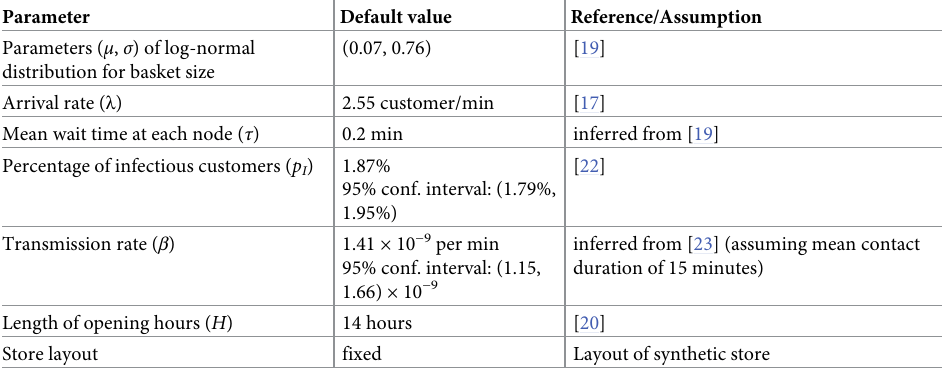
Table 1. Parameter values in our agent-based model. We list uncertainty bounds, when available. Parameter Default value Reference/Assumption Parameters ( μ , σ ) of log-normal (0.07, 0.76) [19] distribution for basket size Arrival rate ( λ ) 2.55 customer/min [17] Mean wait time at each node ( τ ) 0.2 min inferred from [19] Percentage of infectious customers ( p I ) [22] 1.95%) Transmission rate ( β ) inferred from [23] (assuming mean contact duration of 15 minutes) Length of opening hours ( H ) [20] Store layout fixed Layout of synthetic